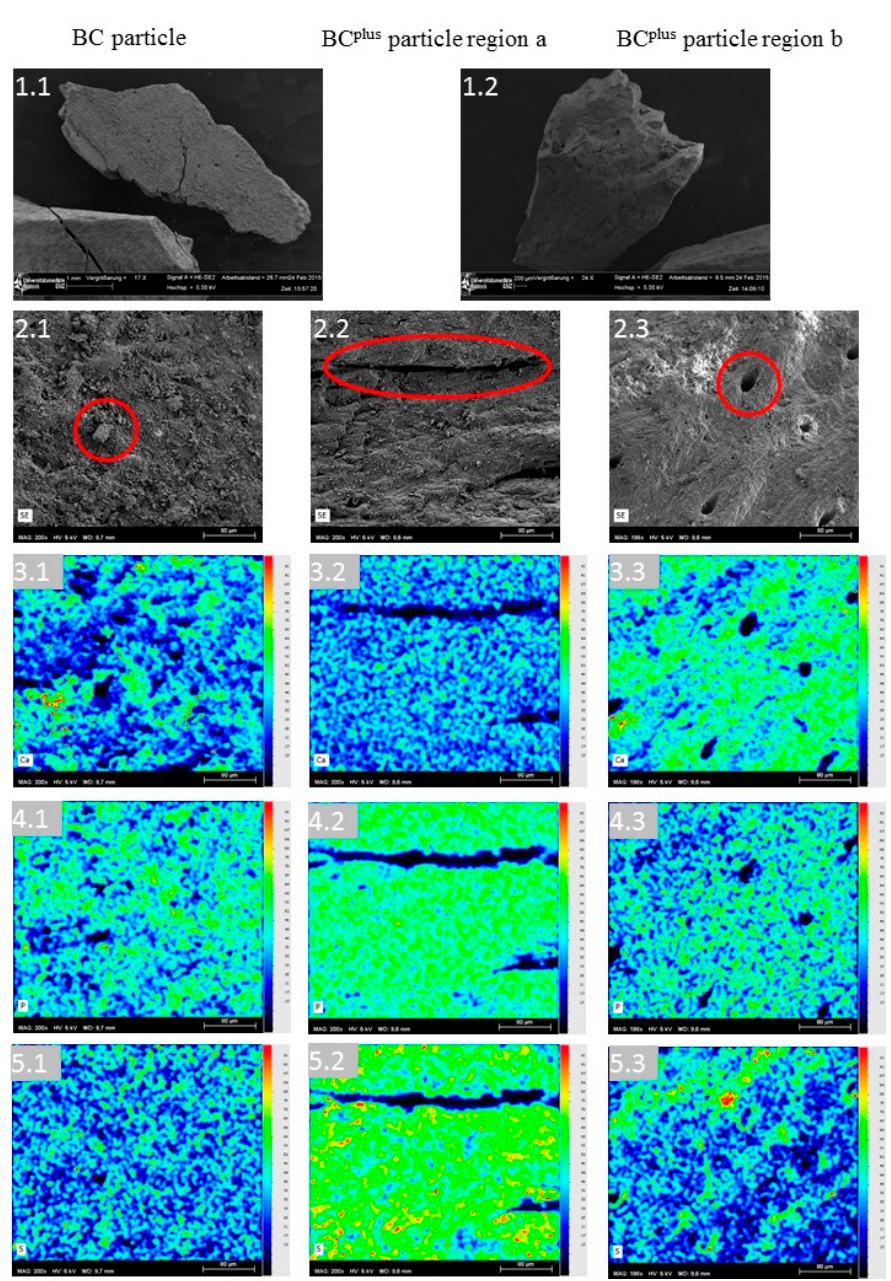
Figure 1. Electron microscopic images of BC (image 1.1) and BC plus (image 1.2) and spots (BC: image 2.1, BC plus : images 2.2 and 2.3) of mapping and distribution of Ca (BC: 3.1, BC plus : 3.2 and 3.3), P (BC: 4.1, BC plus : 4.2 and 4.3) and S (BC: 5.1, BC plus : 5.2 and 5.3) at the surface of the bone chars BC and BC plus according to the energy dispersive X-ray (EDX) analyses, different colors in the element mappings correspond to different intensities (from low (black) to high (red)) according to the color